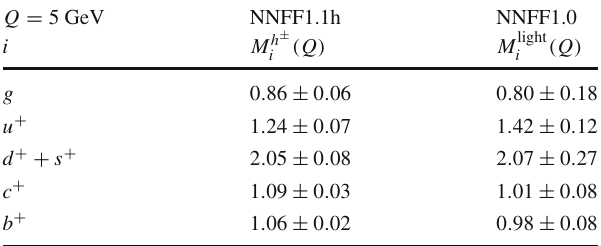
Table 3 The momentum fraction, Eq. (6), for the gluon, u + , d + + s + , c + and b + FF combinations computed at Q = 5 GeV and z min = 0 . 01 for the unidentified charged hadron FFs from NNFF1.1h and for the sum of charged pion, kaon and proton/antiproton FFs from